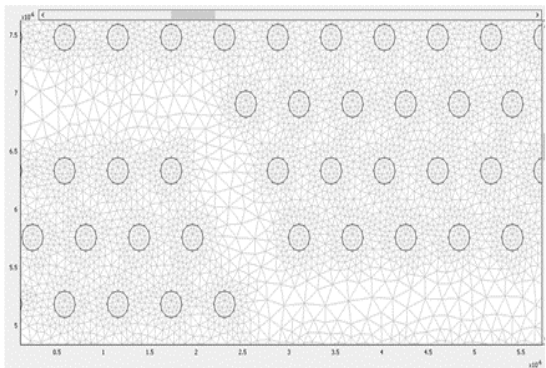
Figure 5 (b): Larger scale of a part of dielectric rectangular as meshed in an FDTD